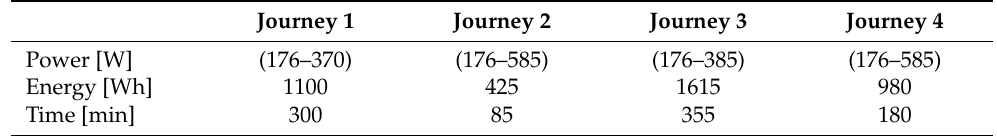
Table 6. Performance features of the four analyzed